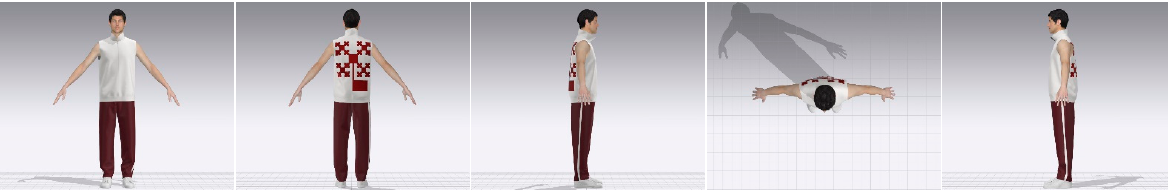
Figure 8. Α third-order Minkowski fractal antenna integrated in a men’s sleeveless zip jumper.